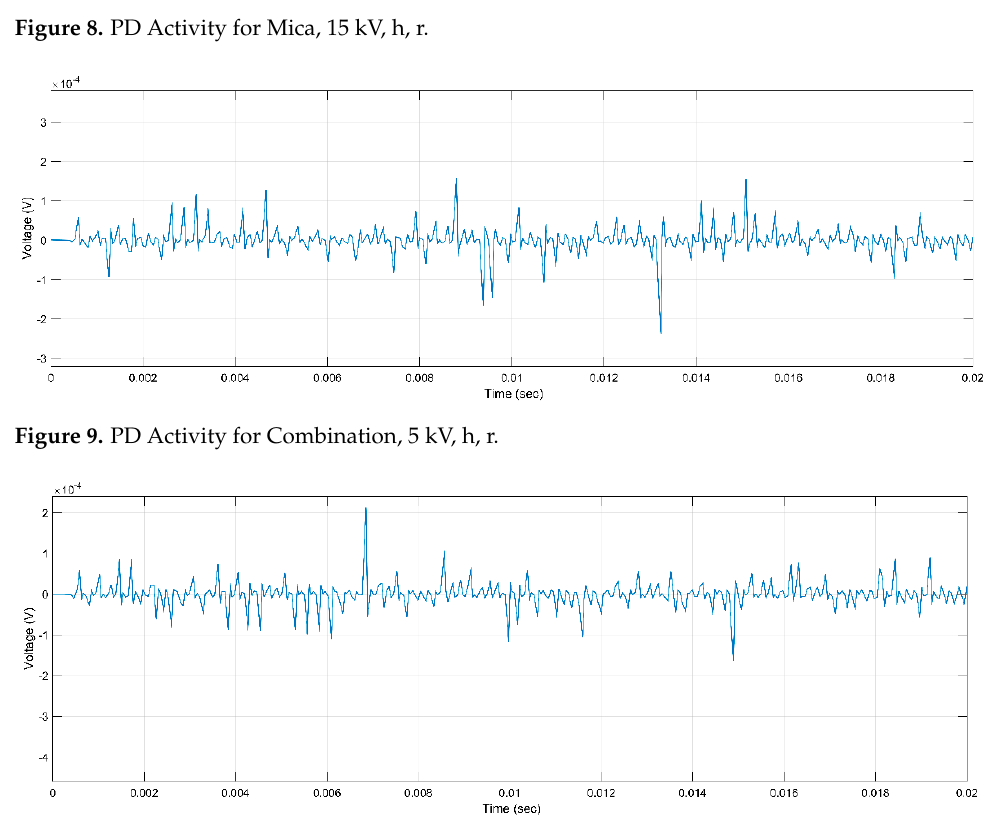
Figure 10. PD Activity for Combination, 10 kV, h, 2 r.